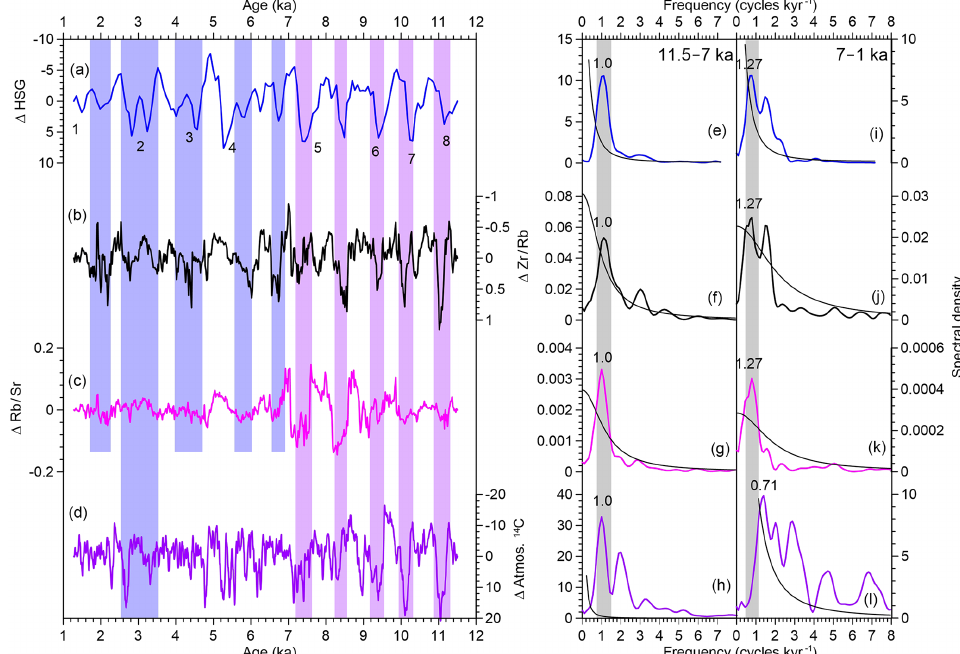
Figure 4. (a–d) Centennial components of (b) Zr / Rb and (c) Rb / Sr with (a) the North Atlantic HSG (Bond et al., 2001) and (d) atmo- sphere 14 C record (Reimer et al., 2013). The purple and blue bars indicate abrupt monsoon events. Plots (e–l) show the spectra of the proxy records during the (e–h) Early and (i–l) Late Holocene. Spectral peaks that are above the 80% confidence levels (black lines) are marked. The grey vertical bands indicate the most significant